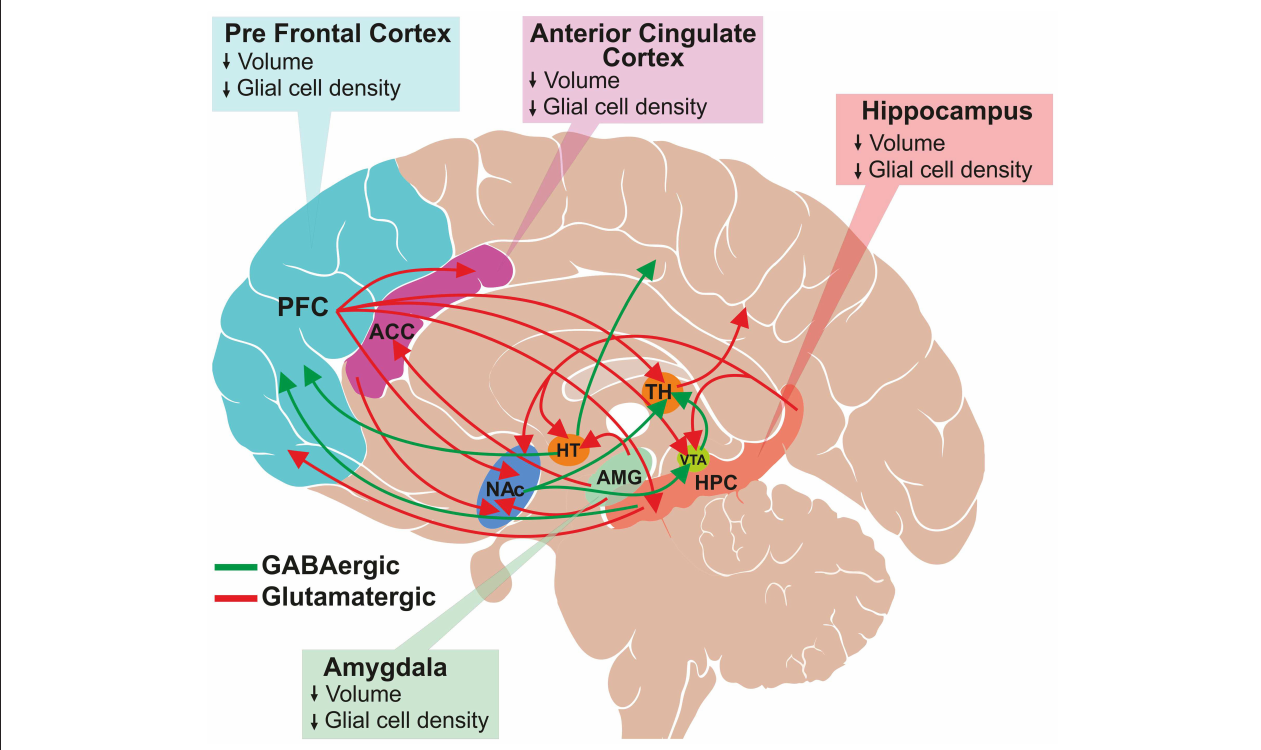
FIGURE 1 | Schematic of glutamatergic and GABAergic projections involved in mood regulation and reward pathway. A subset of several known interconnections among different brain regions are shown. Major glutamatergic projections (red color) arise from the frontal cortex to the anterior cingulate cortex (ACC), thalamus (TH), ventral tegmental area (VTA), hippocampus (HPC) and nucleus accumbens (NAc). Additionally, glutamatergic neurons originate from hippocampus, and innervate into hypothalamus (HT), VTA, NAc and PFC and from amygdala to HT, ACC and NAc. The GABAergic projections (green color) are widely distributed throughout the brain. The major projections that are relevant to this review are from HT to the occipital and parietal cortex, HPC to PFC, and NAc to the thalamus and VTA. The structural changes observed in the brain regions of depressed subjects are shown in the respective